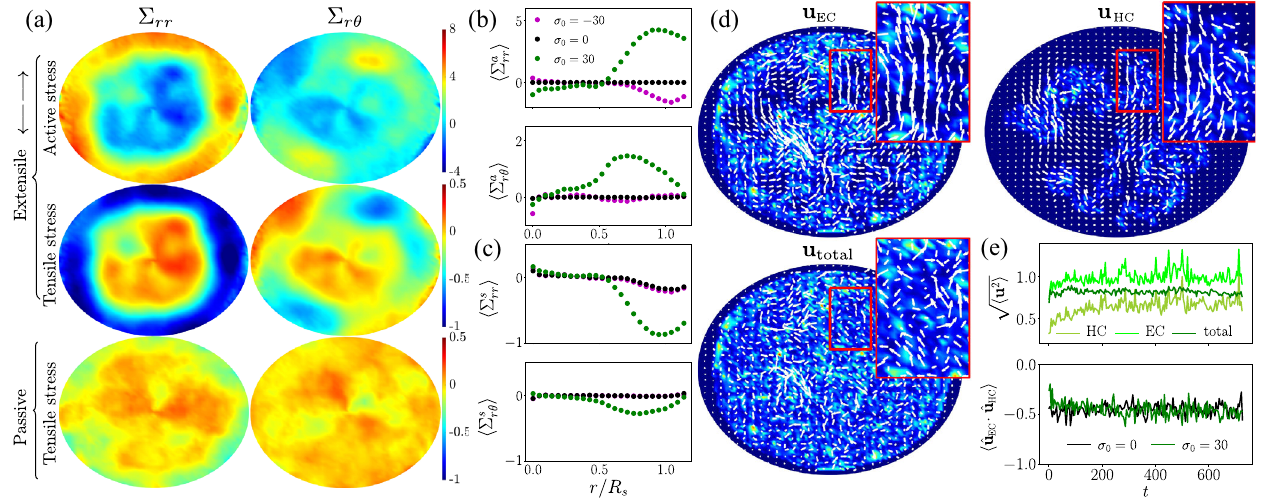
FIG. 4. Analysis of the stress and flow fields. (a) Stress field exerted by dipolar active forces (first row) and internal tensile forces (second and third rows) in a plane containing the major axis of the nucleus, for the active euchromatin case (extensile, σ 0 ¼ 30 , top two rows) and the passive euchromatin case ( σ 0 ¼ 0 , bottom row). The two columns show the radial ( Σ rr ) and shear ( Σ r θ ) components of the stress averaged over t ∈ ½ 350 ; 700 (cid:2) , where ð r; θ Þ are polar coordinates in the plane. (b),(c) Radial variation of active (b) and tensile (c) stress components averaged over the azimuthal direction for extensile ( σ 0 ¼ 30 ), passive ( σ 0 ¼ 0 ), and contractile ( σ 0 ¼ − 30 ) systems. (d) Snapshots of the disturbance flows induced by deterministic forces along EC blocks ( u ) and HC blocks ( u ), as well as EC HC ¼ u þ u total disturbance flow ( u ), for an active extensile system with σ 0 ¼ 30 . The color map shows the magnitude of the total EC HC force distribution, and the vector plot shows the projections of the velocity field in a plane containing the major axis of the nucleus. Insets show enlarged regions where the flows induced by euchromatin and heterochromatin forces clearly oppose one another. (e) Top: ffiffiffiffiffiffiffiffiffi p h u 2 i temporal evolution of the root mean square velocity , showing the stronger flow induced by the euchromatin due to the presence of active dipole forces. Bottom: time evolution of the correlation between the directions of the euchromatin and heterochromatin velocity i , where ˆ u ¼ u = j u j , showing a strong negative correlation. These panels use the data from the simulations · ˆ u fields, defined as h ˆ u EC HC in Fig. 2. Also see videos of the flow fields in the Supplemental Material